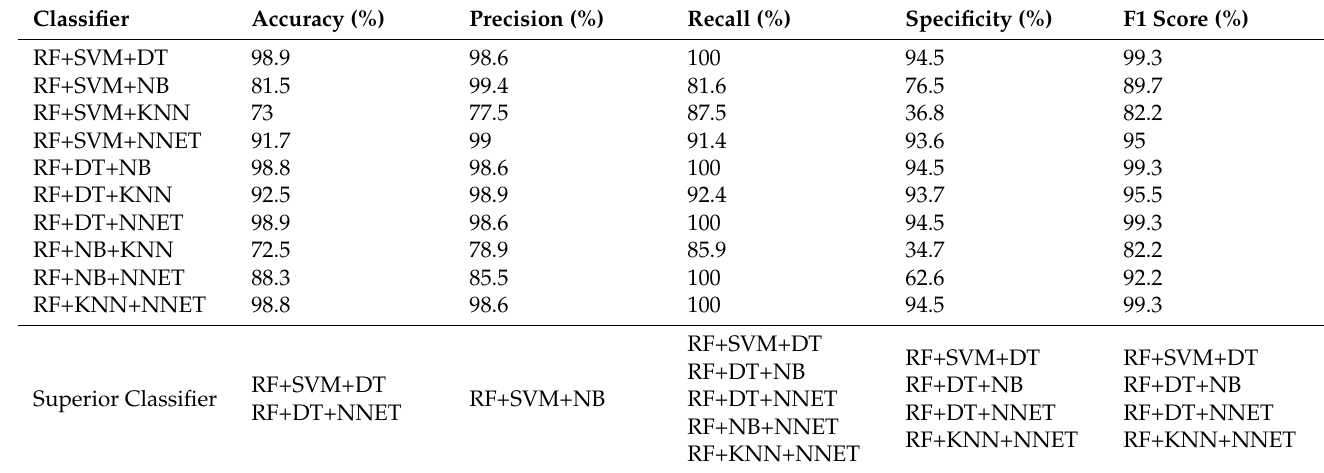
Table 4. Performance comparison of the ensemble classifiers approach on the median imputed